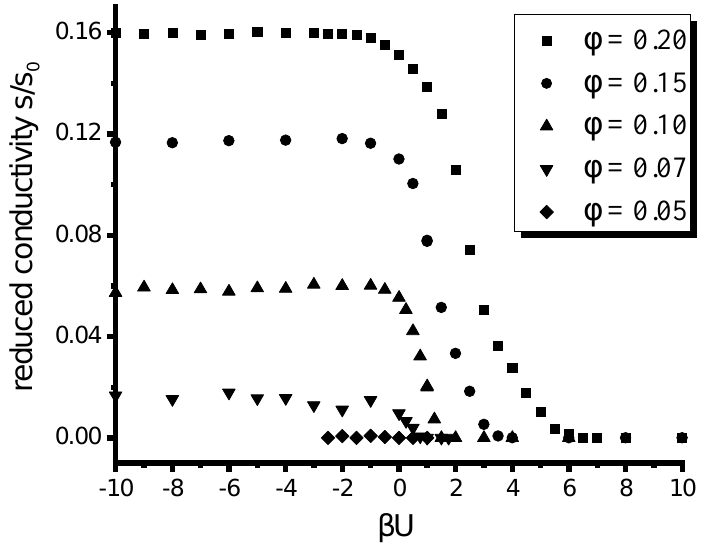
Figure 4. Effect of the interaction between fillers on the conductivity of the filled microphase-separated DBC system for several selected volume fractions of fillers. σ is set equal to 133.1.